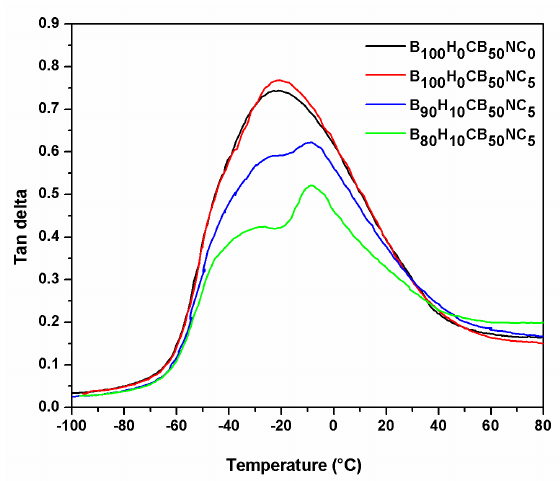
Figure 3: Loss factor (tan delta) as a function of temperature for the nanocomposites. Figure 4: A Comparison of water vapor transmissibility and oxygen permeability with an increase in the polar weight fraction of the samples. Top inset: Formation of polar capillaries increases water vapor transmissibility (Polar path). Bottom inset: Formation of hybrid nanostructures decreases gas permeability (Tortuous path) . The figure depicts some interesting water vapor permeation characteristics which can be explained as follows: